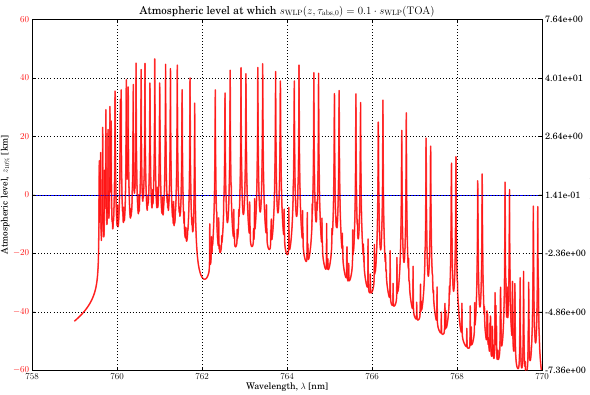
Figure 1. The atmospheric height (red) above the surface at which the reflectance is expected to be reduced to s WLP = 0 . 032 or about 10% of the sensitivity at the top of atmosphere (TOA). Nega- tive heights are unphysical (below the surface) and indicate that all atmospheric levels above the surface are more sensitive than s = 0 . 032. This height is directly proportional to the logarithm of the total absorption optical thickness, shown along the right ordi-